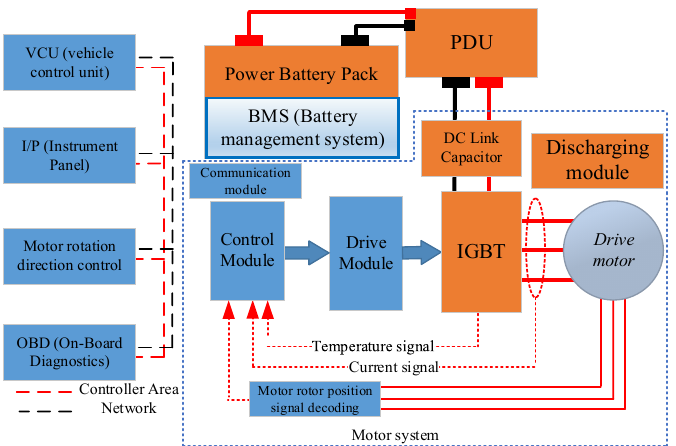
Figure 4. Schematic diagram of the motor system.